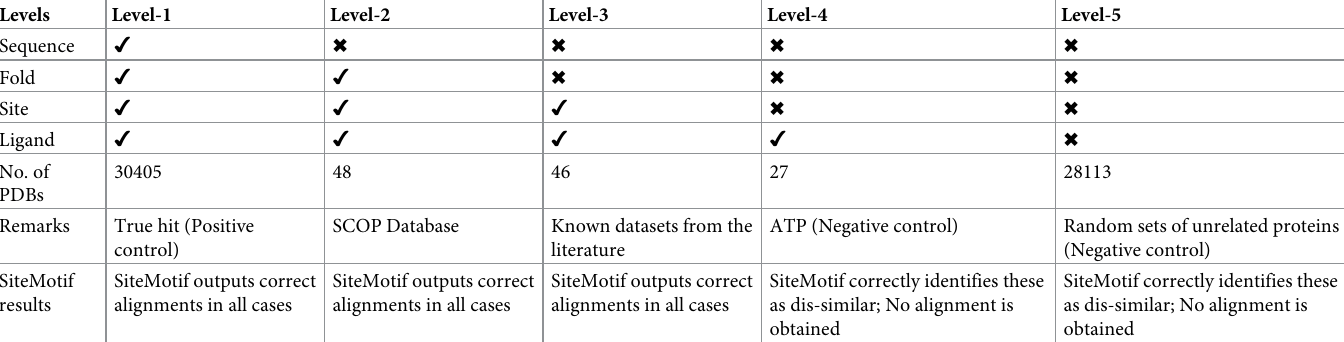
Table 1. Estimating the sensitivity of SiteMotif for proteins sharing similarity at each level. Level-1 constitutes those protein pairs that share high similarity at all levels i.e similar sequence, similar structure, similar binding sites and recognise the same ligand. Whereas for level-2, similarity is observed at all levels except at the sequence with an average sequence identity less than 30%. Level-3 constitutes testing the performance of our method from the known literature reports.